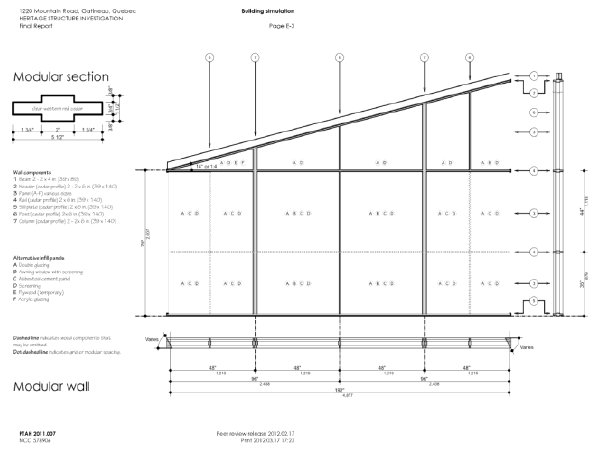
Figure 4. Image of Structural building elements from the HSR (©PTAH Consultants Inc. Architects)